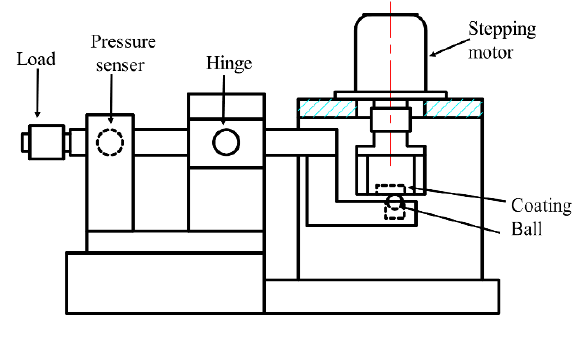
Figure 1: Schematic diagram of ball-on-disc